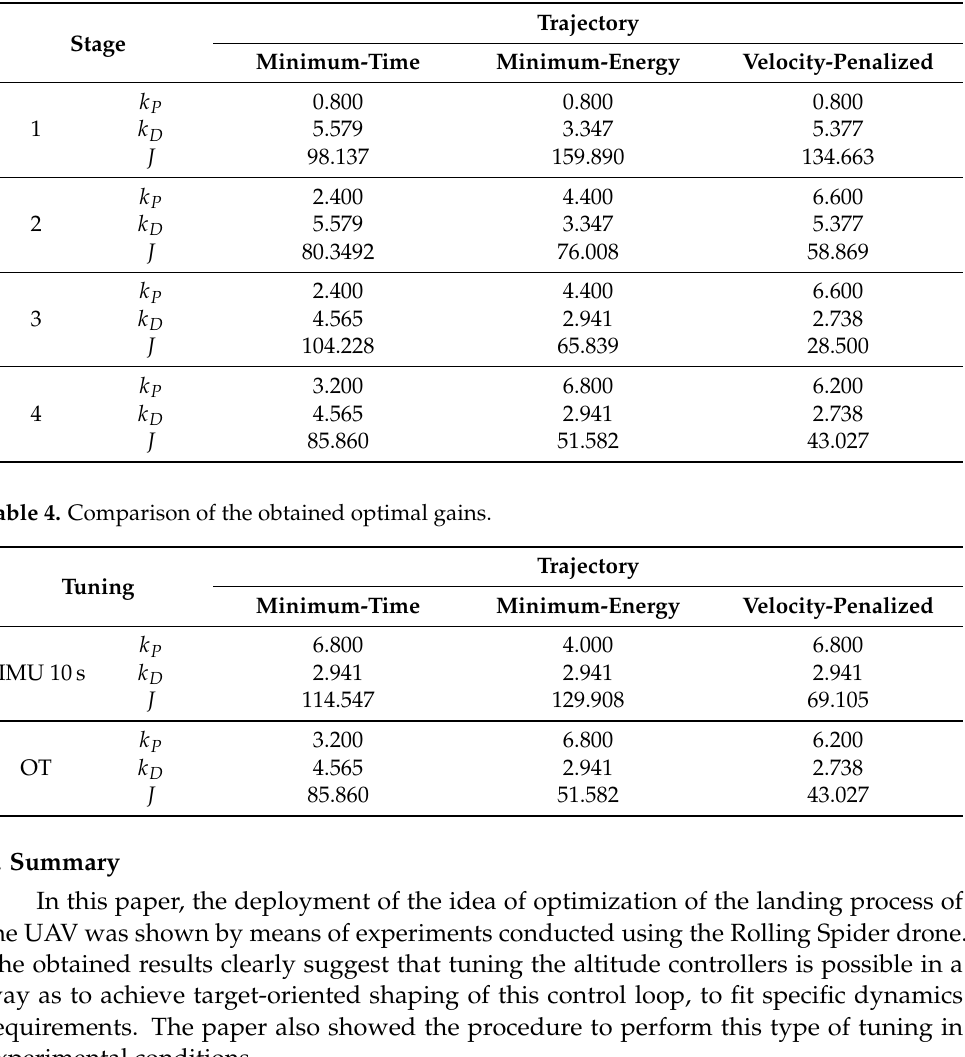
Figure 13. IMU vs. OT performance. Table 3. Optimization of landing on the basis of OT readings.